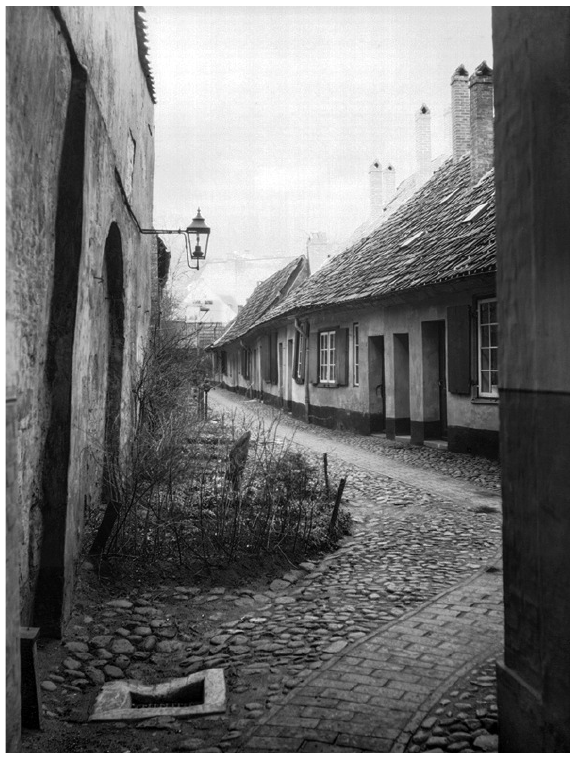
Figure 1. Residential lane off Glockengießerstraße 41–3, Lübeck, constructed in 1612. Source: “Gandorps Gang – Hof” [Gandorps Gang – Courtyard] (1925), © Bildarchiv Foto